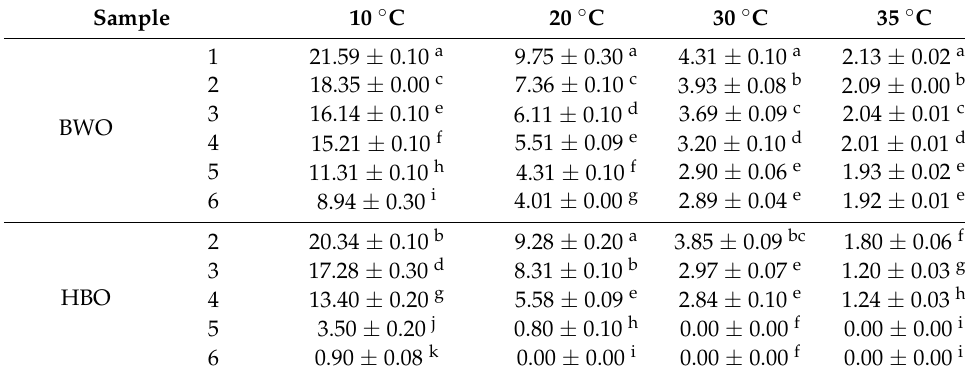
Table 2. Solid fat content (SFC) of margarines prepared with BWO and